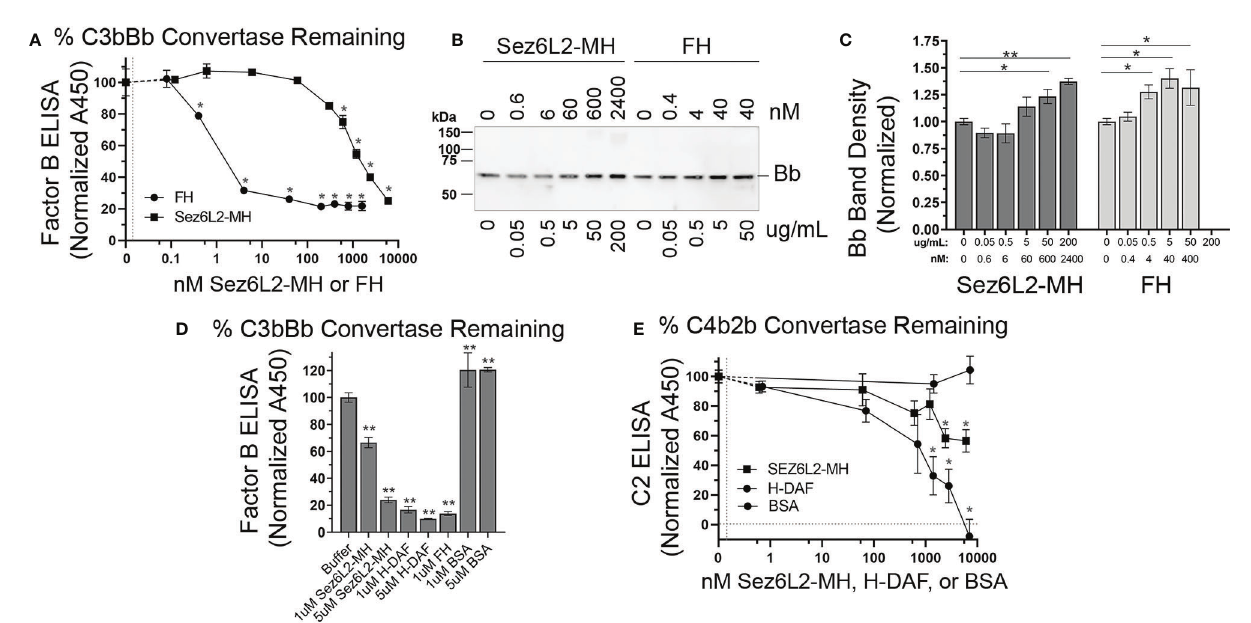
FIGURE 7 | Truncated Sez6L2 has decay accelerating activity for the alternative pathway C3 convertase but has only modest decay accelerating activity for the classical/lectin pathway C3 convertase. (A – D) Alternative C3 convertase assay: (A – C) A 96 well plate coated with C3b was incubated with Factor B and Factor D to form the C3 convertase C3bBb, then incubated with Sez6L2-MH or FH at various concentrations ranging from 0-6000 nM (equivalent to 0-500 µg/mL) to assess their decay accelerating activity. Factor B remaining bound to the plate (as C3bBb) was detected using an anti-Factor B antibody ELISA in (A) and Bb released into the supernatant is shown via western blot in (B) with Bb band densities quanti fi ed in (C) . For the western blot and quanti fi cation, Sez6L2-MH and FH concentrations are listed in both nM and µg/mL. Quanti fi cation of Bb band densities were normalized to the 0 nM control lanes. N=3 samples per group. (D) The alternative C3 convertase decay ELISA described above was repeated comparing 0, 1uM, and 5uM of Sez6L2-MH, H-DAF, FH, and BSA. (E) Classical C3 convertase assay: A plate coated with C4b was incubated with C2 and C1s-enzyme to form the classical/lectin pathway C3 convertase C4b2b, then incubated with Sez6L2-MH, H-DAF at concentrations ranging from 0 to 7000 nM to assess their decay accelerating activity. C2 remaining bound to the plate (presumably as C4b2b) was detected using an anti-C2 antibody ELISA. For A, D, and E ELISAs: N=3 (1 experiment with 3 replicates; representative of 2-3 independent experiments). Statistics: one-way ANOVAS with Holms-Sidak multiple comparison ’ s tests to controls. *p < 0.05, **<